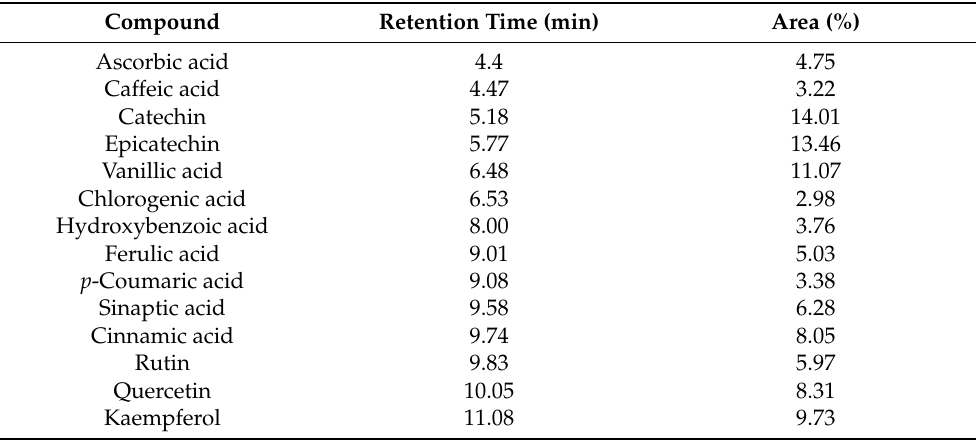
Table 4. LC–Orbitrap-MS analysis of Hericium